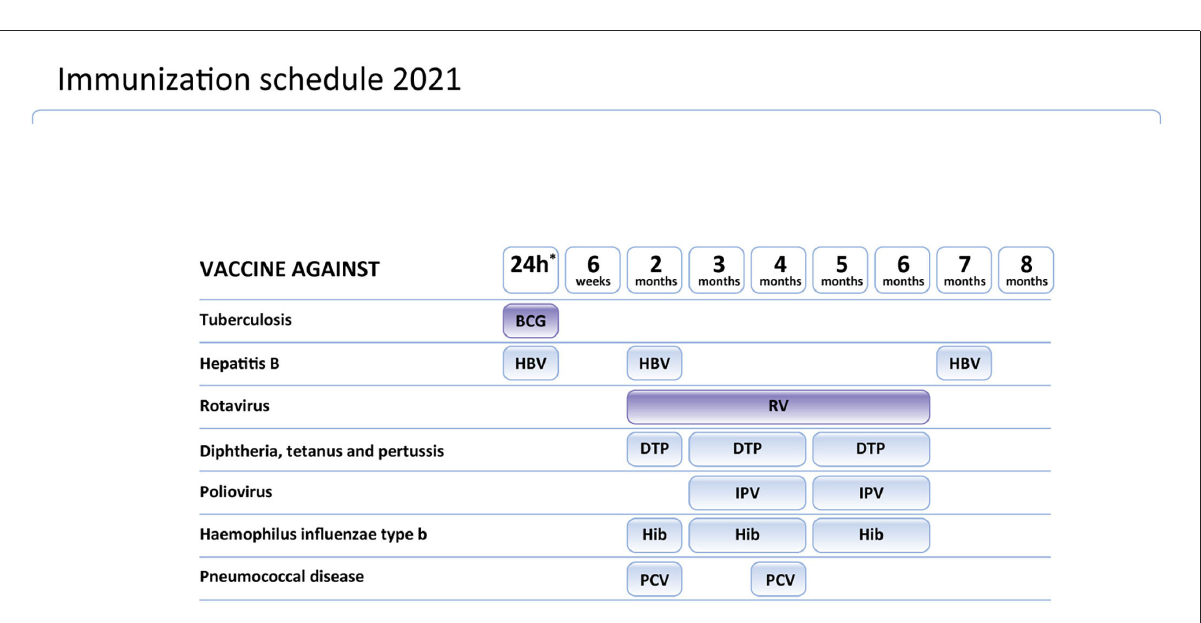
FIGURE3 Vaccination calendar in Poland in